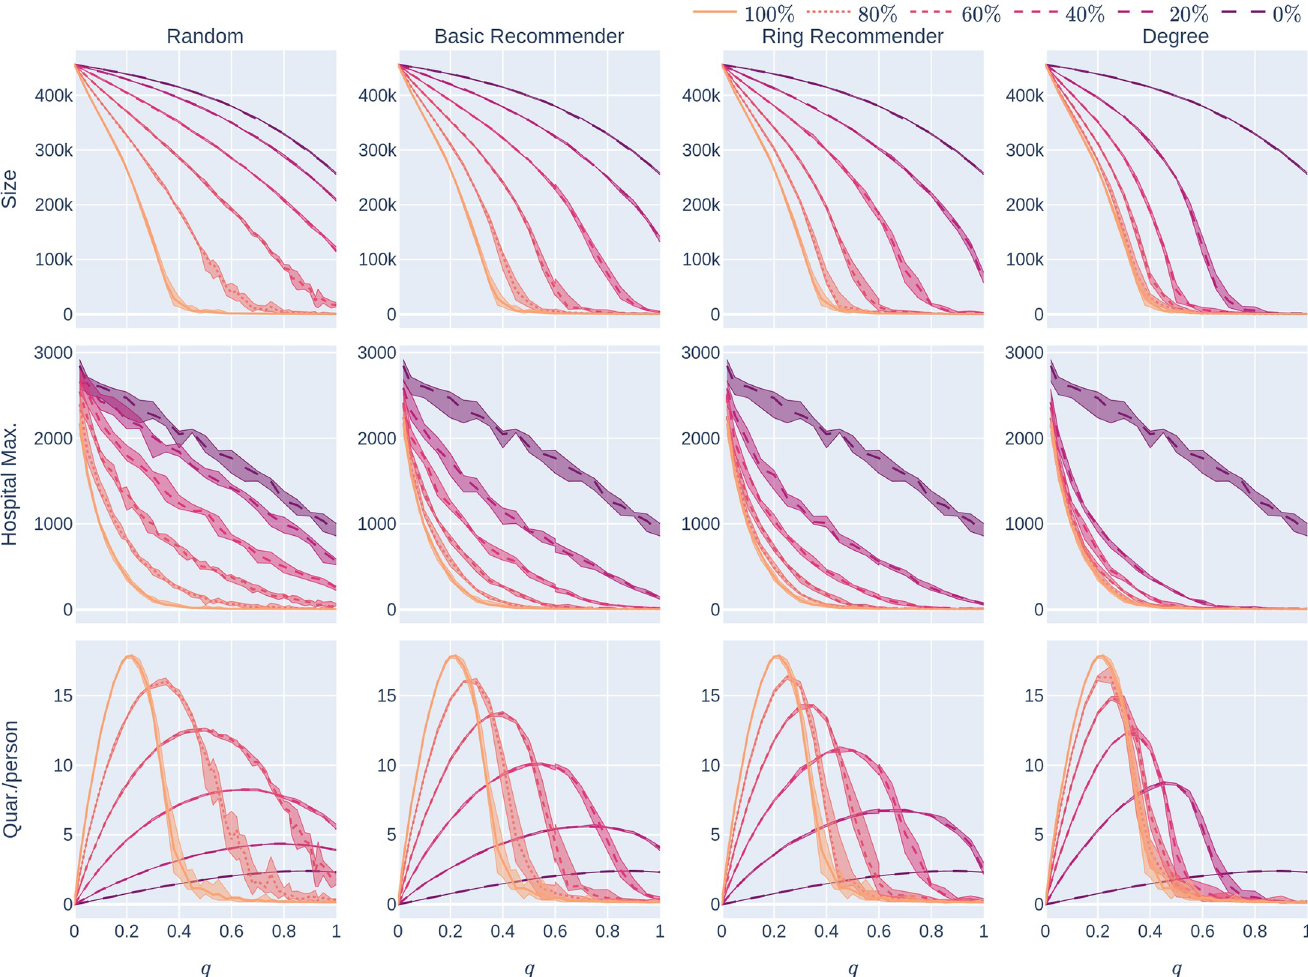
Fig 8. Influence of the quarantine strictness q for various uptake percentages p % and the four uptake scenarios: The KPIs are plotted against q , the quarantine strictness. We work here with a fixed underlying network, a 500,000 node GIRG with τ = 3.3 (fewer super-spreaders) and α = 2.3 (more geometric). Each column represents a given uptake scenario (random, basic-recommender and ring-recommender, and degree-targetted). The x -axis shows the quarantine strictness q varying from 0 to 1 at step size 0.05. Simulations are done for the 21 values of q corresponding to these steps. There is an additional simulation point at 0.02 (in order to avoid division by 0 in the computation for HMax and still have a point close to 0). The y -axis shows the corresponding value of the KPI. The curves on each figure correspond to the different uptake percentages, as labelled. For each parameter value, the plotted result is the median over 5 runs. The shaded region around the plot covers the results of all 5 simulations. The epidemic is started by infecting 100 individuals, chosen uniformly at random. Simulation is halted when there are no more exposed or infected vertices. The infection rate is β =